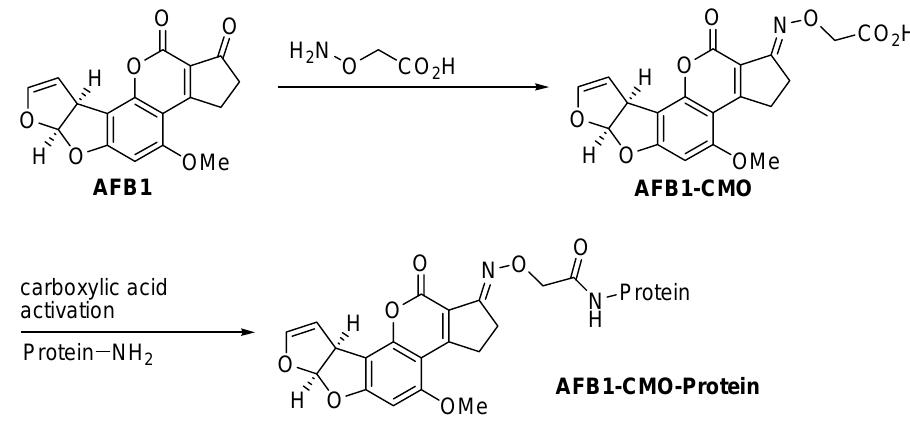
Figure 2. Conventional aflatoxin B1 conjugation via its carboxymethyl oxime developed by Chu and Ueno [8,